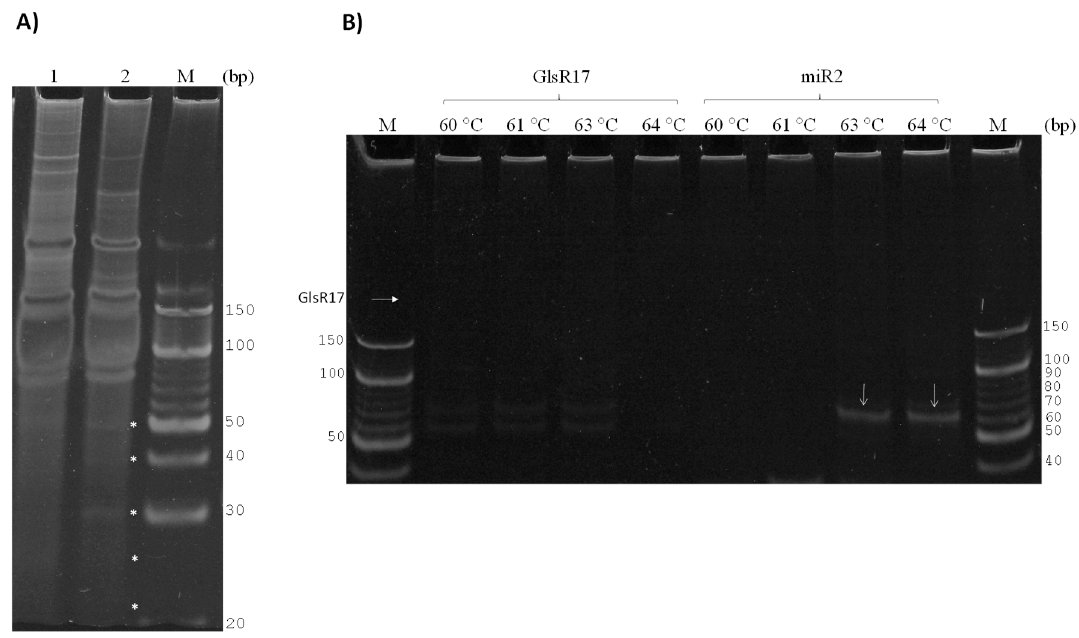
Figure 3. Size selection and gel extraction of small RNAs from total RNA and identification of PCR-amplified fragments of miR2. ( A ) Small RNAs obtained with sizes smaller than 100 bp copurified from total RNA (lane 1) and small RNA (lane 2), previously shown in Figure 2A. * Indicates bands of small RNAs between sizes 20 and 50 bp; ( B ) PCR was performed to verify the absence of GlsR17 and confirm the presence of miR2 in samples of small RNA less than 100 bp. Gradient of temperature was performed and the amplicons were observed on a 16% polyacrylamide gel.